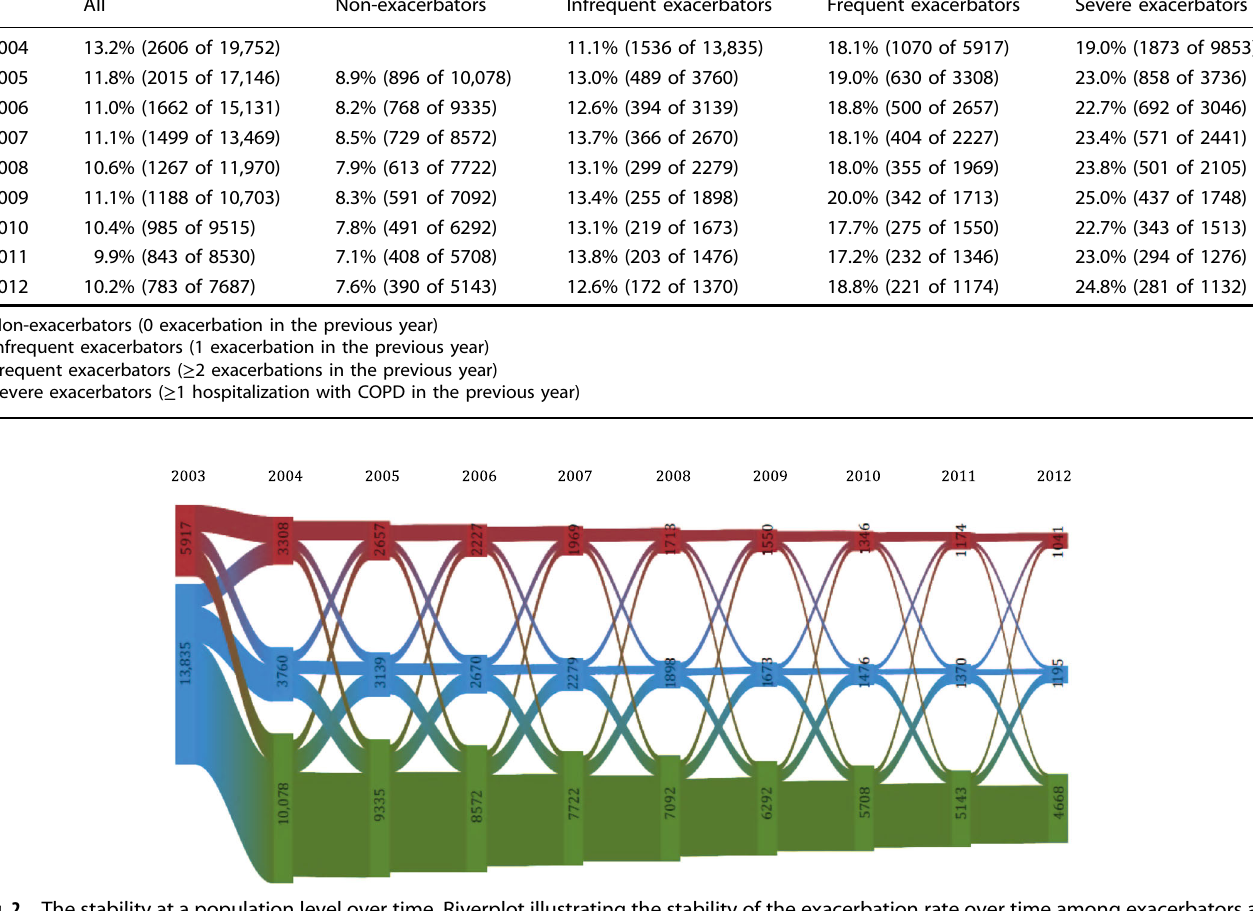
Fig. 2 The stability at a population level over time. Riverplot illustrating the stability of the exacerbation rate over time among exacerbators at baseline. The size of the nodes is proportional to the percentage of individuals classi fi ed as frequent exacerbators, infrequent exacerbators and non-exacerbators, respectively. The thickness of the links between categories illustrates the size of the fl ow, i.e., the proportion of COPD patients within each category who are classi fi ed as either frequent exacerbators, infrequent exacerbators and non-exacerbators in the following year. The difference in volume between links and nodes represents the number of deaths each year. Red Frequent exacerbators ( ≥ 2 exacerbations in the given year); Blue Infrequent exacerbators (1 exacerbation in the given year); Green Non-exacerbators (0 exacerbations in the given